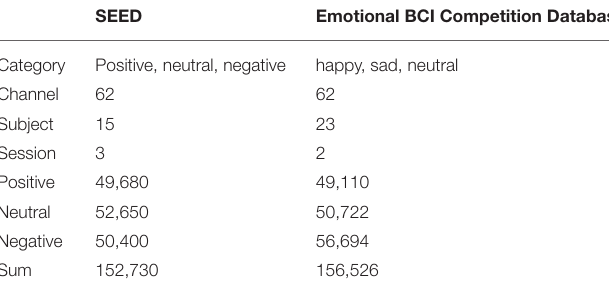
TABLE 1 | Details of the two experimental